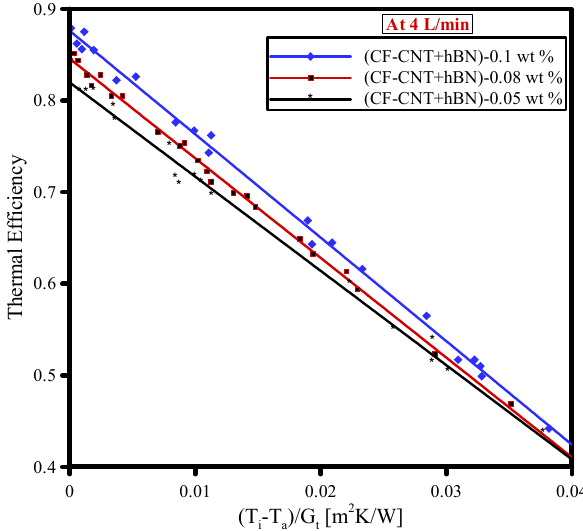
Figure 15. Effect of various mass flow rates of water-based nanofluids on thermal efficiency.